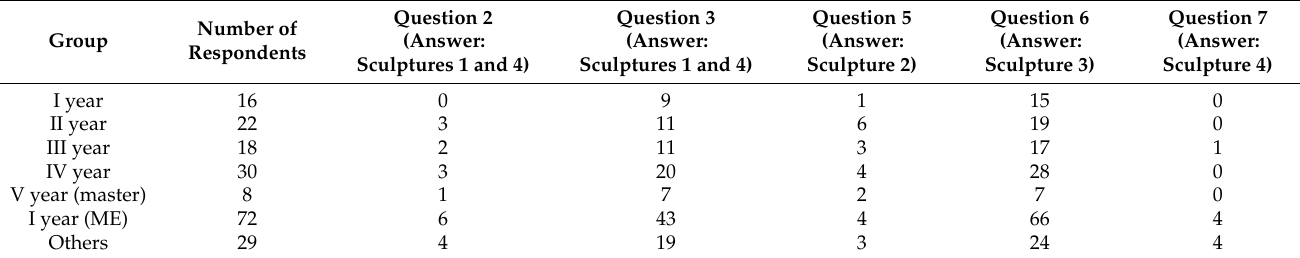
Table 2. Analysis of respondents’ answers to survey